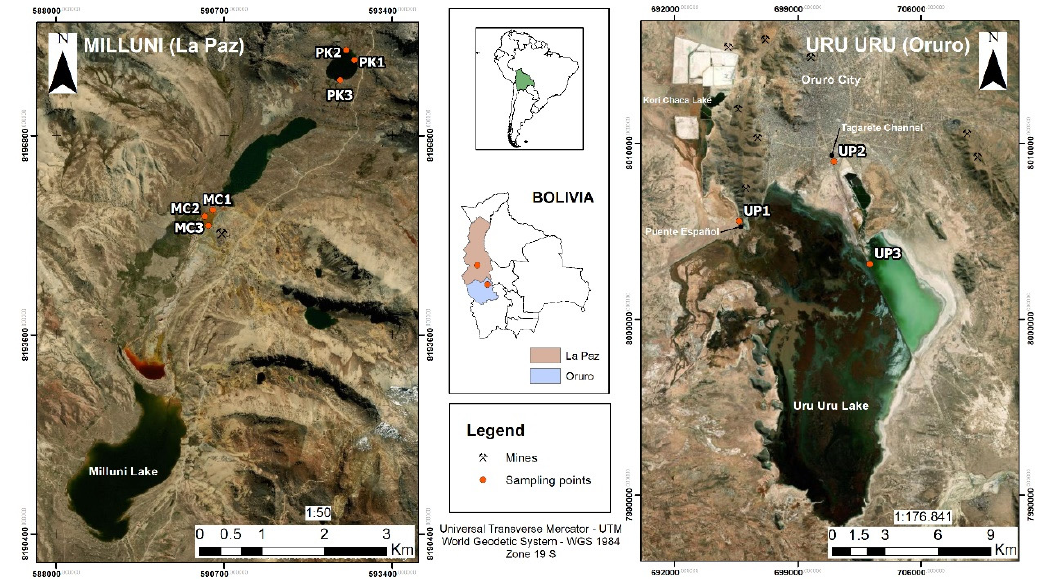
Figure 1. Study area. The left panel shows the sampling sites in the Milluni Valley. Three samples were collected from both lakes, the pristine Pata Khota (PK) and Milluni Chico (MC). MC is located directly downstream of the Mine “ La Fabulosa .” The right panel shows the sampling sites in the Uru Uru Lake, in the department of Oruro: UP1 is located at the channel that discharges the water of the meromictic lake Kori Chaca an old open-pit gold mine, UP2 is located at the Tagarete channel that carries untreated wastewater discharges from Oruro city, and UP3 is located in the northeast part of Uru Uru Lake, and receives the discharges of both mining residues and wastewater.